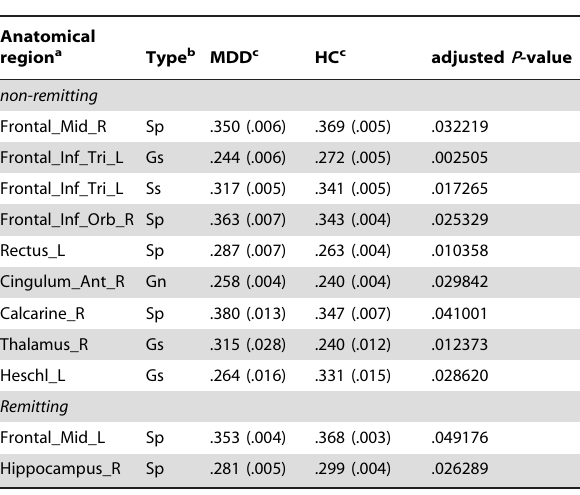
Table 2. Comparison of cortical shape complexities estimated by mean curvedness between non-remitting and remitting MDD patients in contrast with healthy